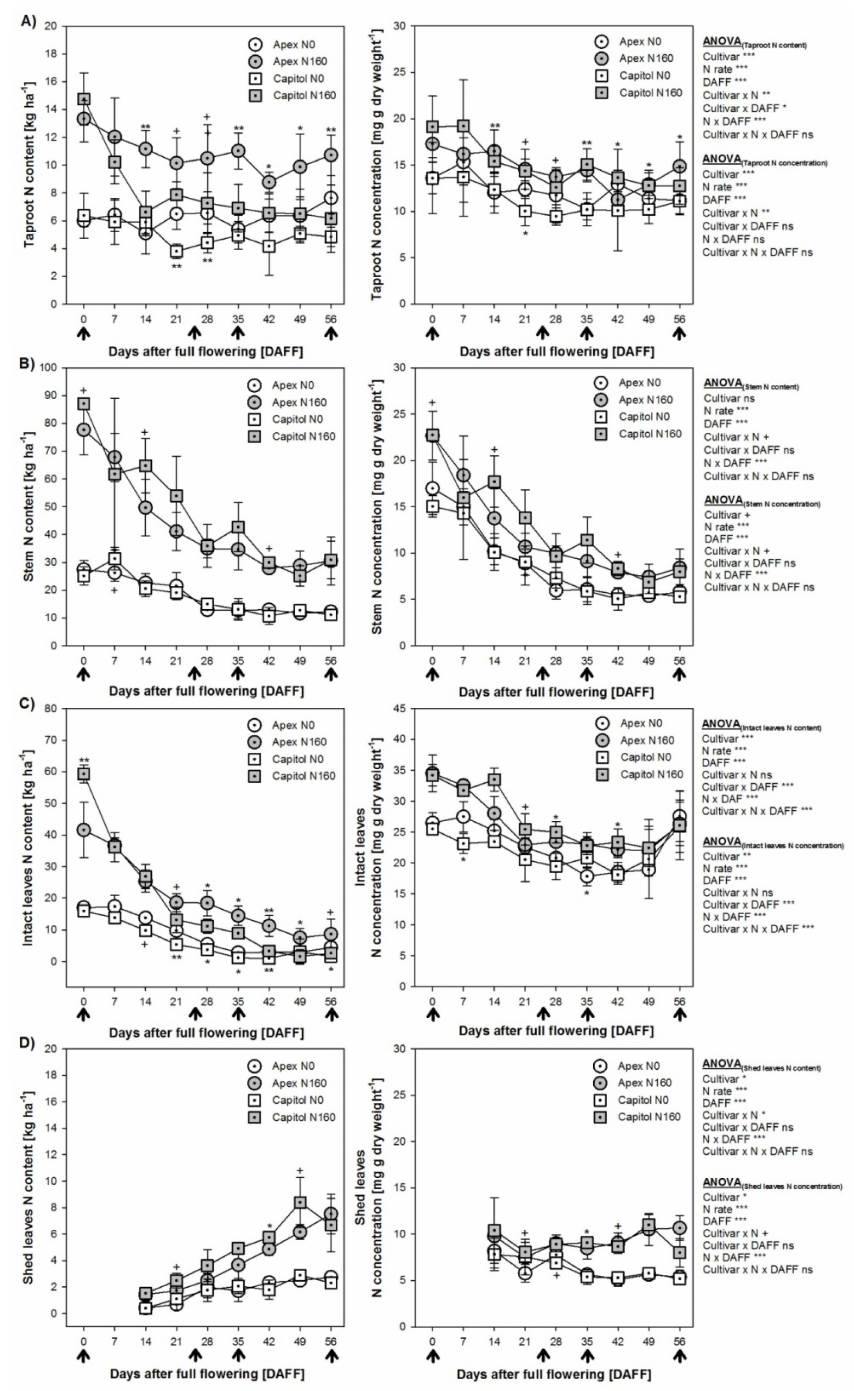
Figure 7. Nitrogen content ( left ) and concentration ( right ) of the ( A ) taproot, ( B ) stem; ( C ) intact leaves and ( D ) shed leaves from full flowering until maturity of the winter oilseed-rape line-cultivars Apex and Capitol as affected by N fertilization rate (N0 and N160). The arrows indicate the developmental stages BBCH79 and BBCH89. ANOVA: +, * , ** , and *** indicate significant differences at p < 0.10, p < 0.05, p < 0.01, and p < 0.001, respectively. ns = non-significant. Individual DAFF: +, * , ** , and *** indicate significant differences between the cultivars within the N fertilization rates at p < 0.10, p < 0.05, p < 0.01, and p < 0.001, respectively. The error bars (visible only when greater than the symbols) represent the standard deviations of the means ( n =